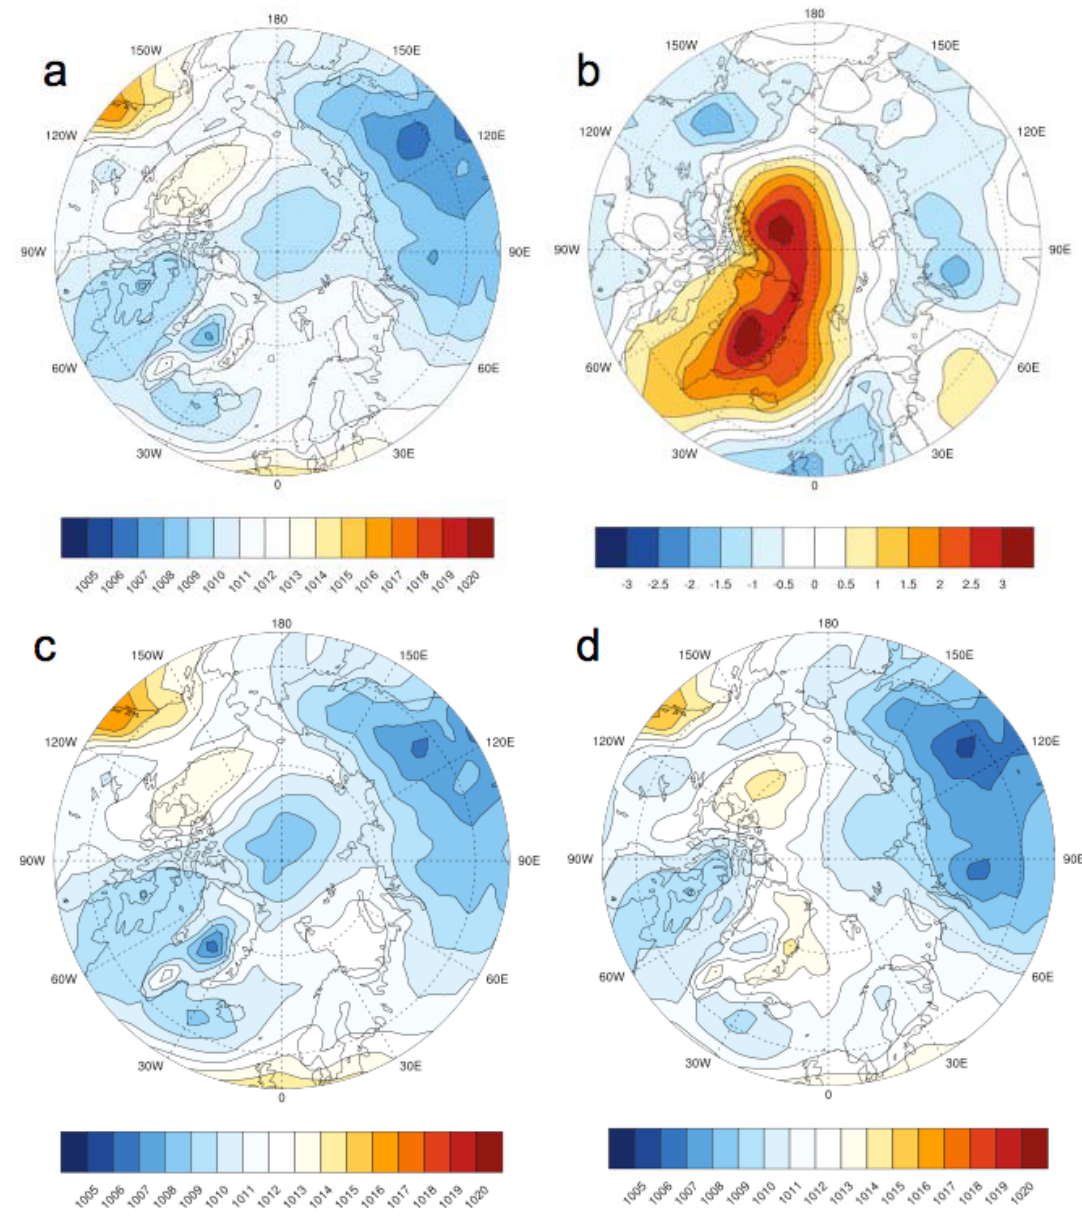
Figure 7. June to August averaged sea level pressure (slp) ( a ) climatology